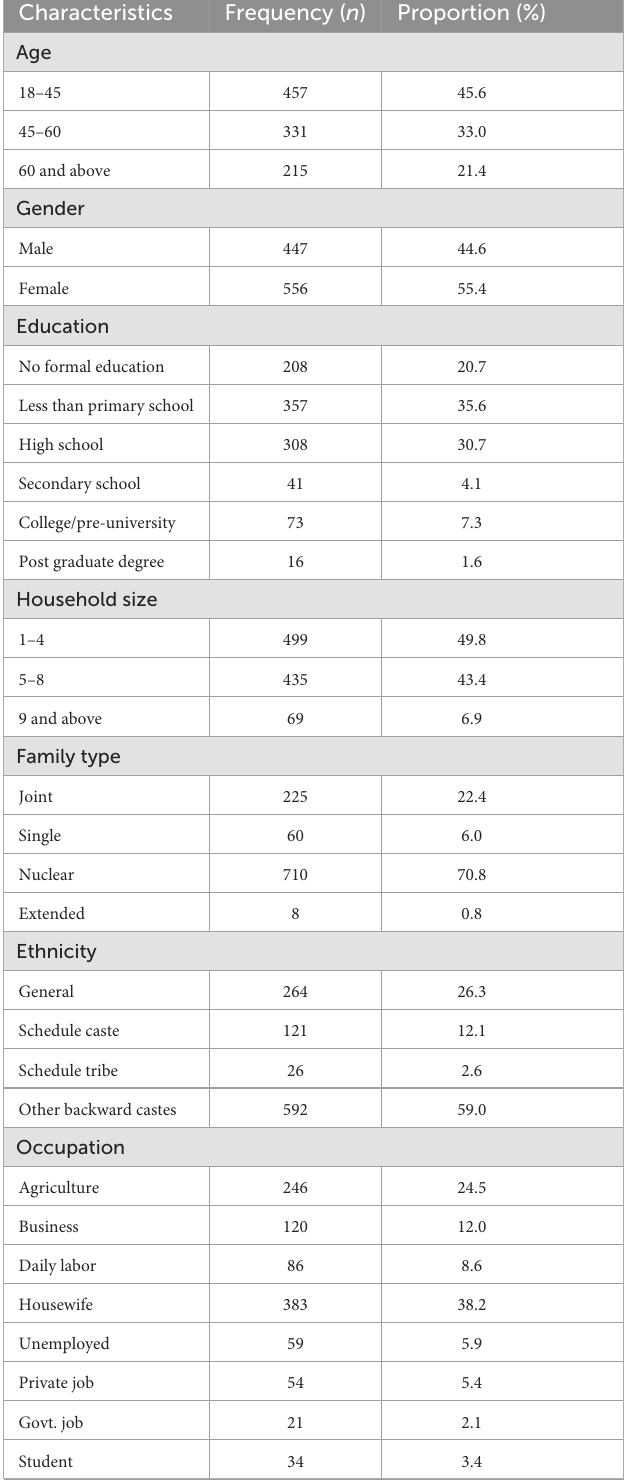
TABLE 1 Socio-demographic characteristics of the rural study participants.